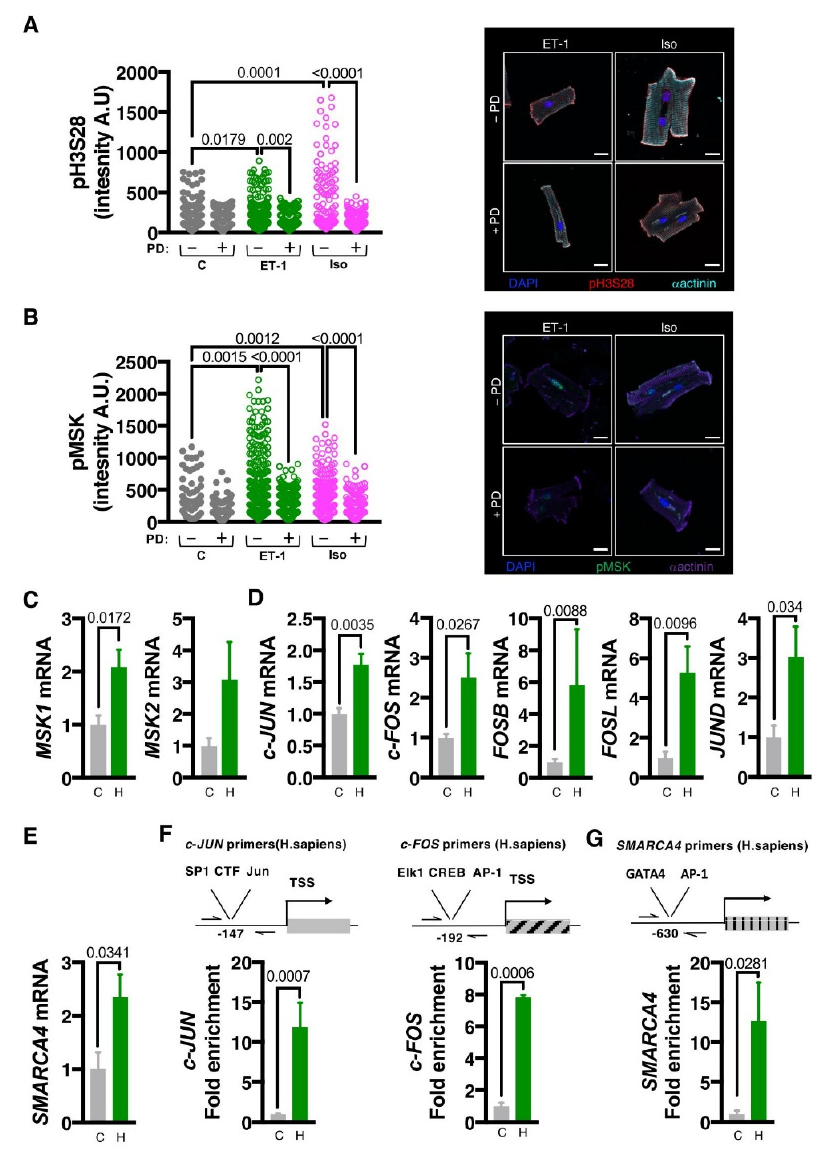
Figure 4. The MAPK-MSK-pH3S28 axis is conserved in the hypertrophic response in humans. ( A ). Confocal immunofluorescence analysis of pH3S28 in isolated human donor CM treated for 15 min with ET-1 or Iso ± PD. Left : Quantification of immunostaining of nuclear pH3S28. Right : Representative images of isolated CM stained for pH3S28 (red), α -Act (cyan), nuclei stained with DAPI (blue). N = 4, 12–123 cells per sample. Scale bar = 20 µm. ( B ). Confocal immunofluorescence analysis of pMSK in isolated immunostaining in isolated human donor CM, treated for 15 min with ET-1 or Iso +/ − PD. Left : Quantification of immunostaining of nuclear pMSK. Right : Representative images of isolated CM stained for pMSK (green), α -Act (purple), nuclei stained with DAPI (blue). N = 4, 14–124 cells per sample. Scale bar = 20 µm. ( C – E ). RT-qPCR analysis of mRNA expression of indicated genes in human hypertrophic left ventricular tissue (H) compared with non-failing (C). In Figure 5C,E, C, N = 5, H, N = 4. In Figure 5D, C, N = 4, H, N = 4. ( C ). RT-qPCR analysis of MSK1 and MSK2 mRNA expression. ( D ). RT-qPCR analysis of expression of immediate early gene components of the AP-1 transcription factor complex. ( E ). RT-qPCR analysis of SMARCA4 ( BRG-1) . ( F ). ChIP-qPCR analysis for pH3S28 enrichment at the c-JUN and c-FOS promoters in PCM-1 +ve CM nuclei from human hypertrophic left ventricular tissue (H) compared with non-failing (C). N = 3. ( G ). ChIP-qPCR for pH3S28 enrichment at the SMARCA4 promoter in PCM-1 +ve CM nuclei from human hypertrophic left ventricular tissue (H) compared with non-failing (C). N = 3.